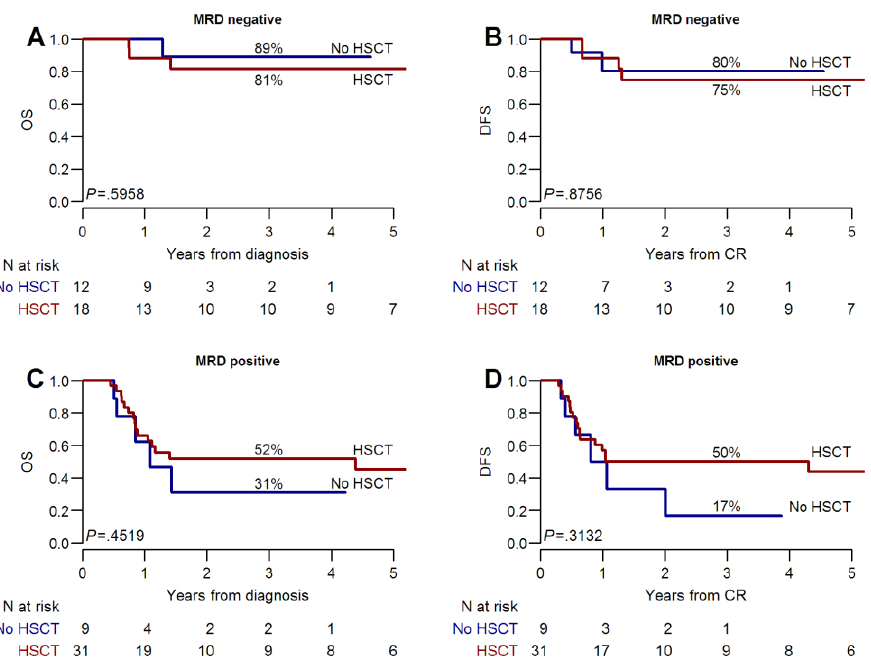
Figure 2. Overall survival and disease free survival according to alloHSCT. ( A ) and ( B ): patients with negative MRD after consolidation chemotherapy; ( C ) and ( D ): patients with positive MRD after consolidation chemotherapy.